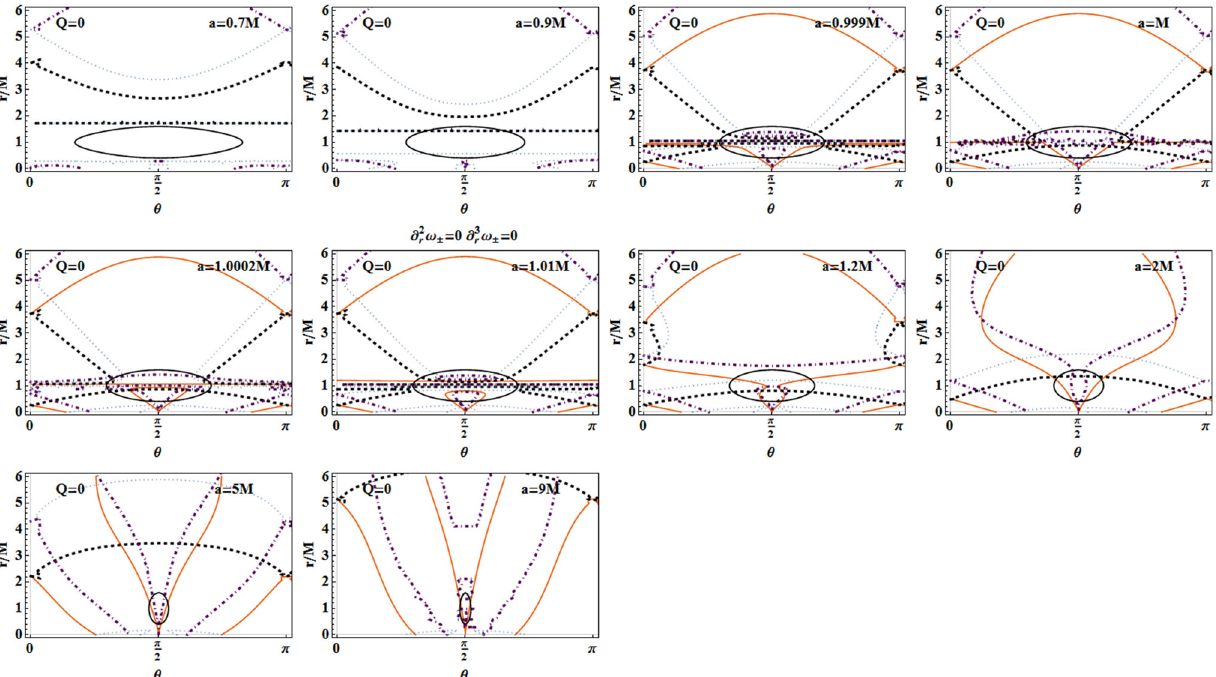
Fig. 31 Kerr geometries: off-equatorial case. Solutions of ∂ 2 r ω ± = 0 (orange and dashed curves) and ∂ 3 r ω ± = 0 (dotted and dotted-dashed curves), defining the Killing bottlenecks of naked singularities, g tt = 0